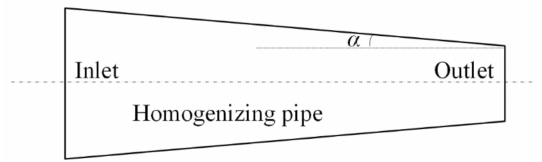
Figure 16. Special-shaped homogenizing pipe.